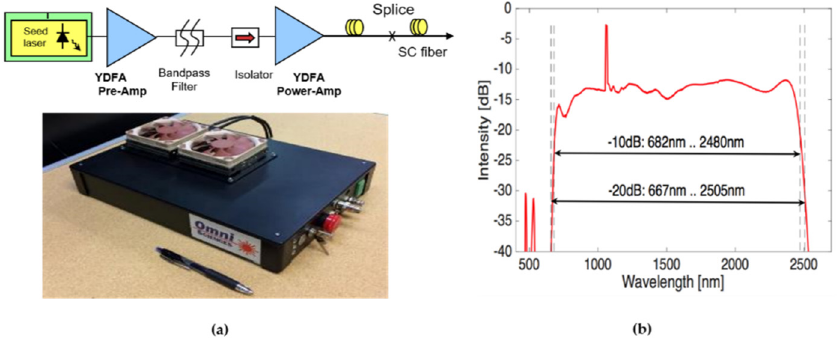
Figure 2. ( a ) Photograph of the 10-W SCL and a block diagram of the SCL used in this study. ( b ) Output spectrum of the super-continuum light source. ( b ) Output spectrum of the super-continuum light